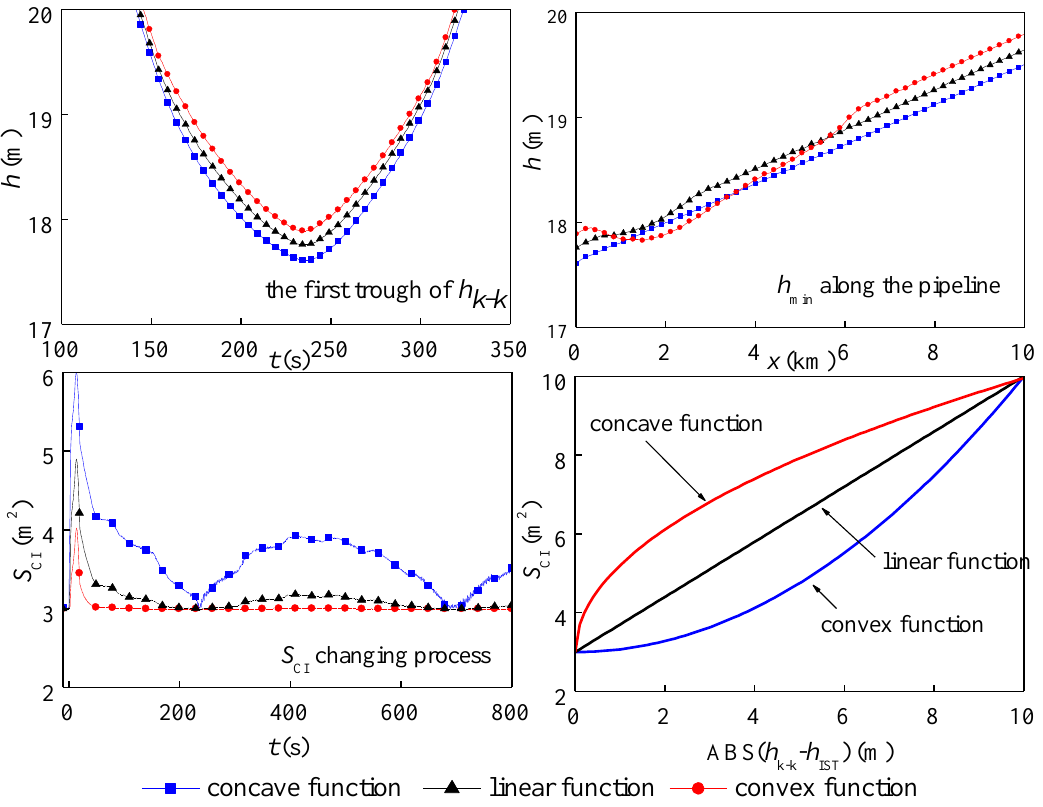
Figure 13. Comparison of the three functions of the IST.